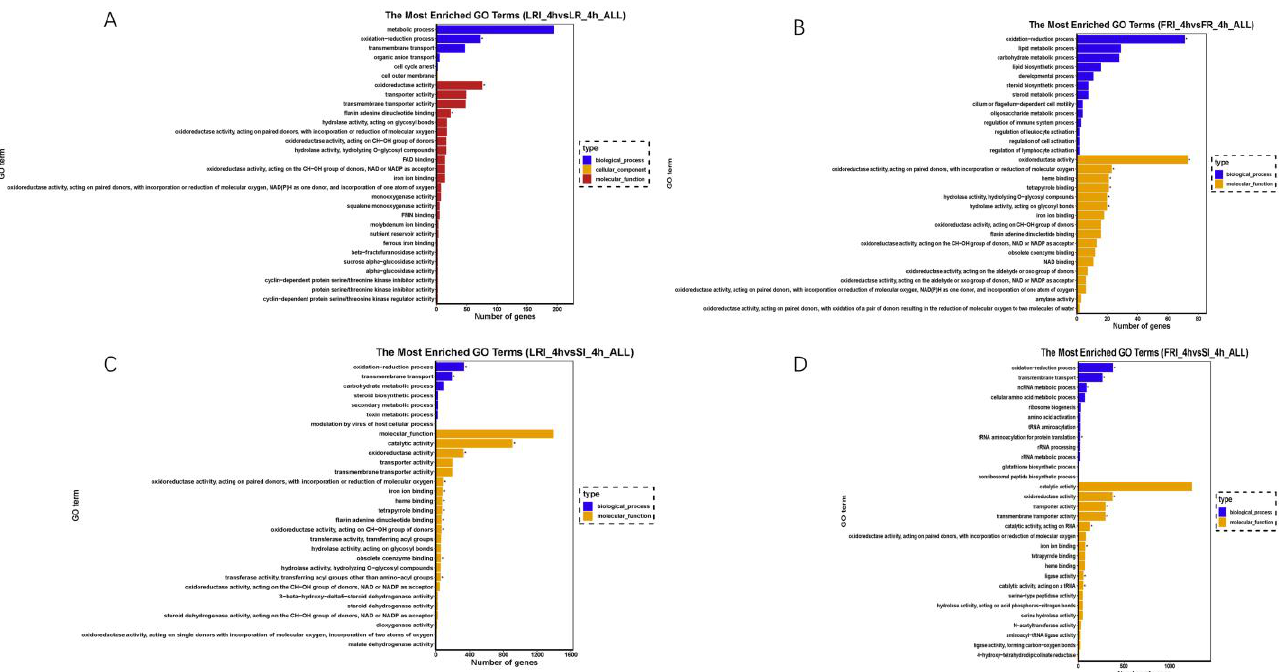
Figure 5. Gene ontology (GO) classifications of the DEGs for LRI_4h vs. LR_4h ( A ), FRI_4h vs. FR_4h ( B ), LRI_4h vs. SI_4h ( C ), and FRI_4h vs. SI_4h ( D ). Each GO category (type) displays 30 terms (listed on the Y-axis) significantly or most enriched for the DEGs in the given comparisons, and the X-axis indicates the number of DEGs involved in the particular GO term.